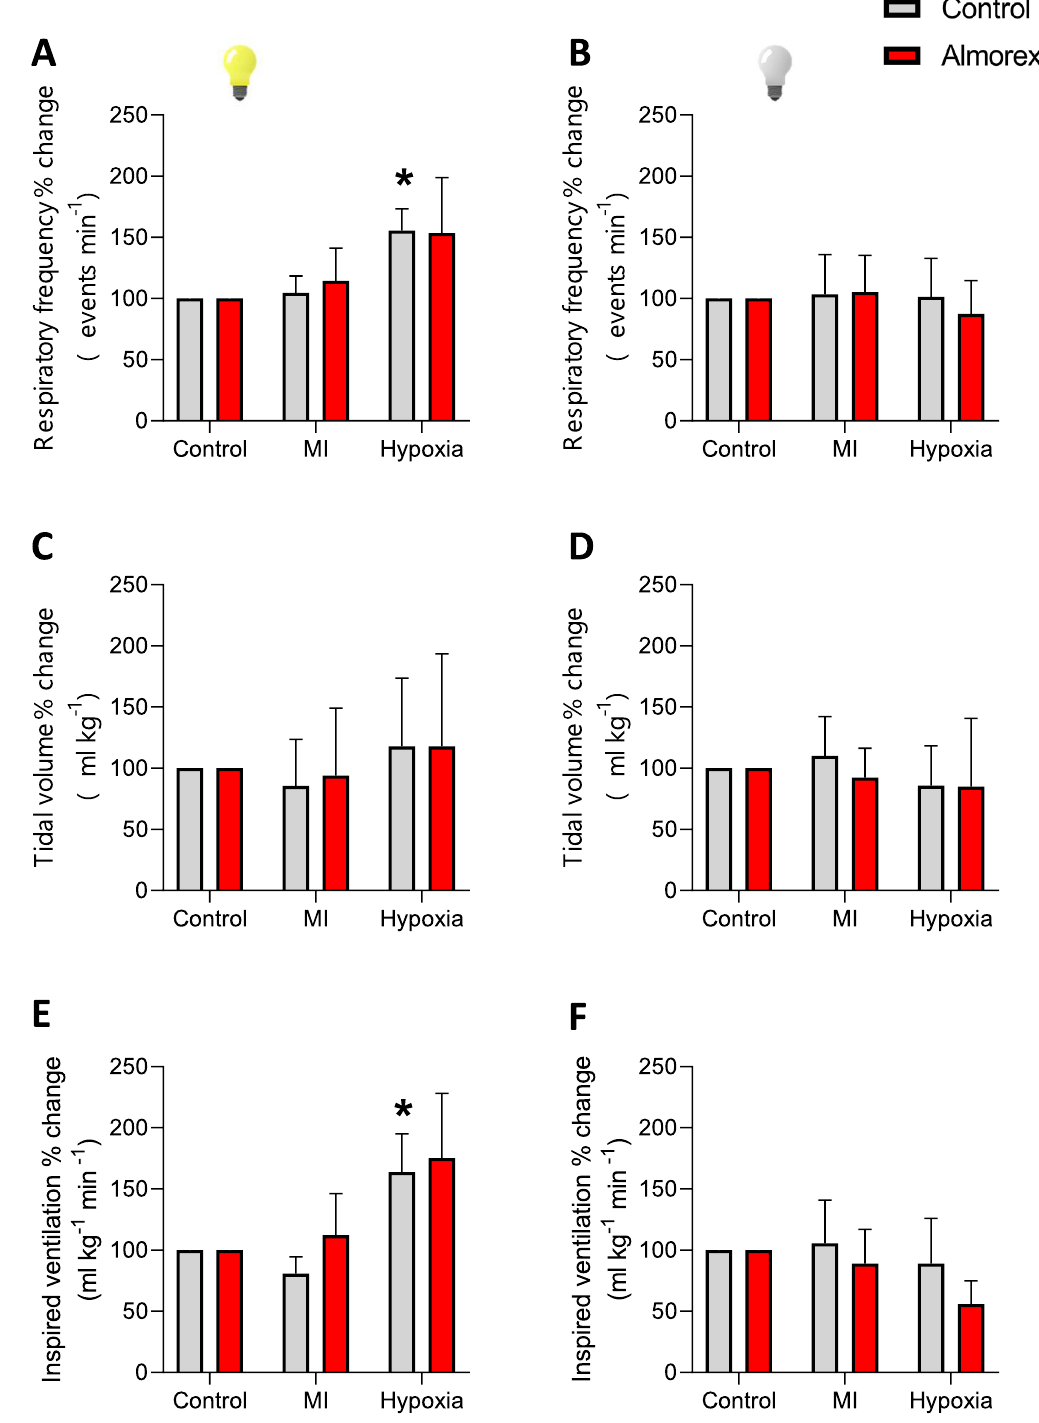
Figure 7. Effect of Almorexant on hypoxic chemoreflex. Effect of the i.c.v. microinjection (MI) of Almorexant ˙ V and its vehicle on f R , V T and I in green iguanas exposed to acute hypoxia (5% O 2 ) during light or dark phases. Data reported as means ± s.e.m. The effect of hypoxia (vehicle group, no drug) is indicated by * compared to control, while + represent the statistical differences caused by the effect of the